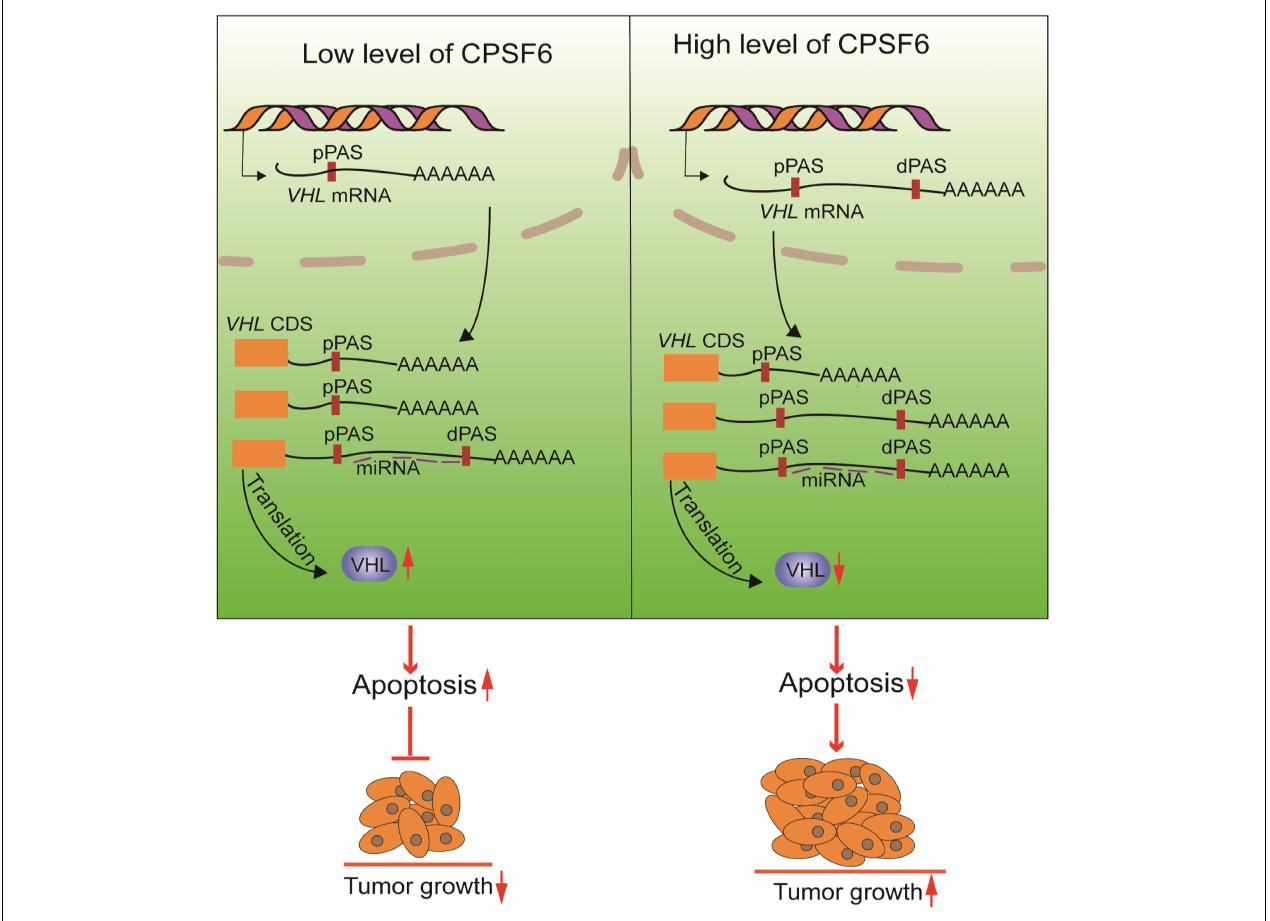
FIGURE 7 | The proposed mechanism of CPSF6 in tumorigenesis of GC